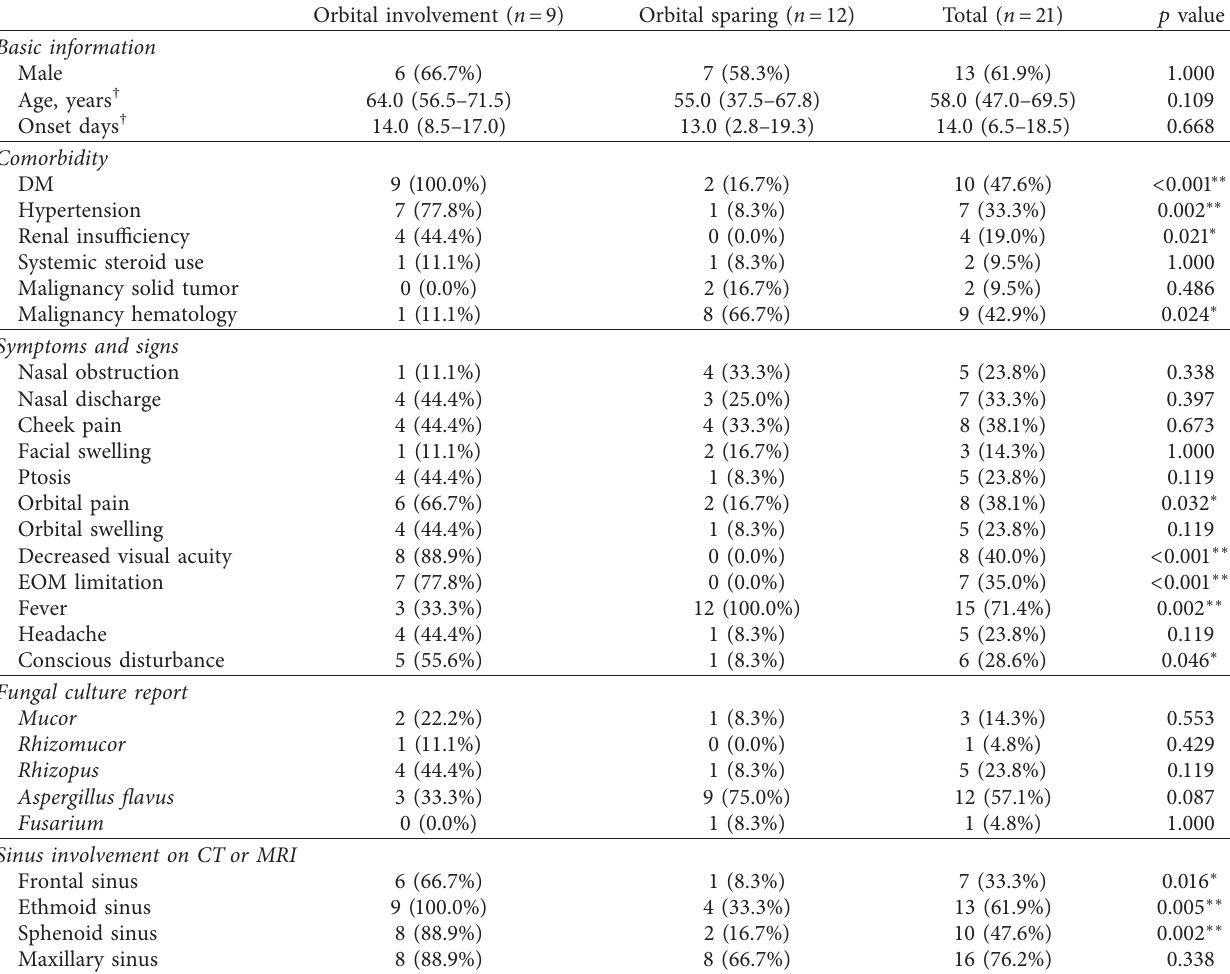
Table 1: Comparison of patients’ characteristics, symptoms and signs, culture reports, and image findings between the orbital-involved and sparing group in patients diagnosed with AIFRS (DM: diabetes mellitus; EOM: extraocular